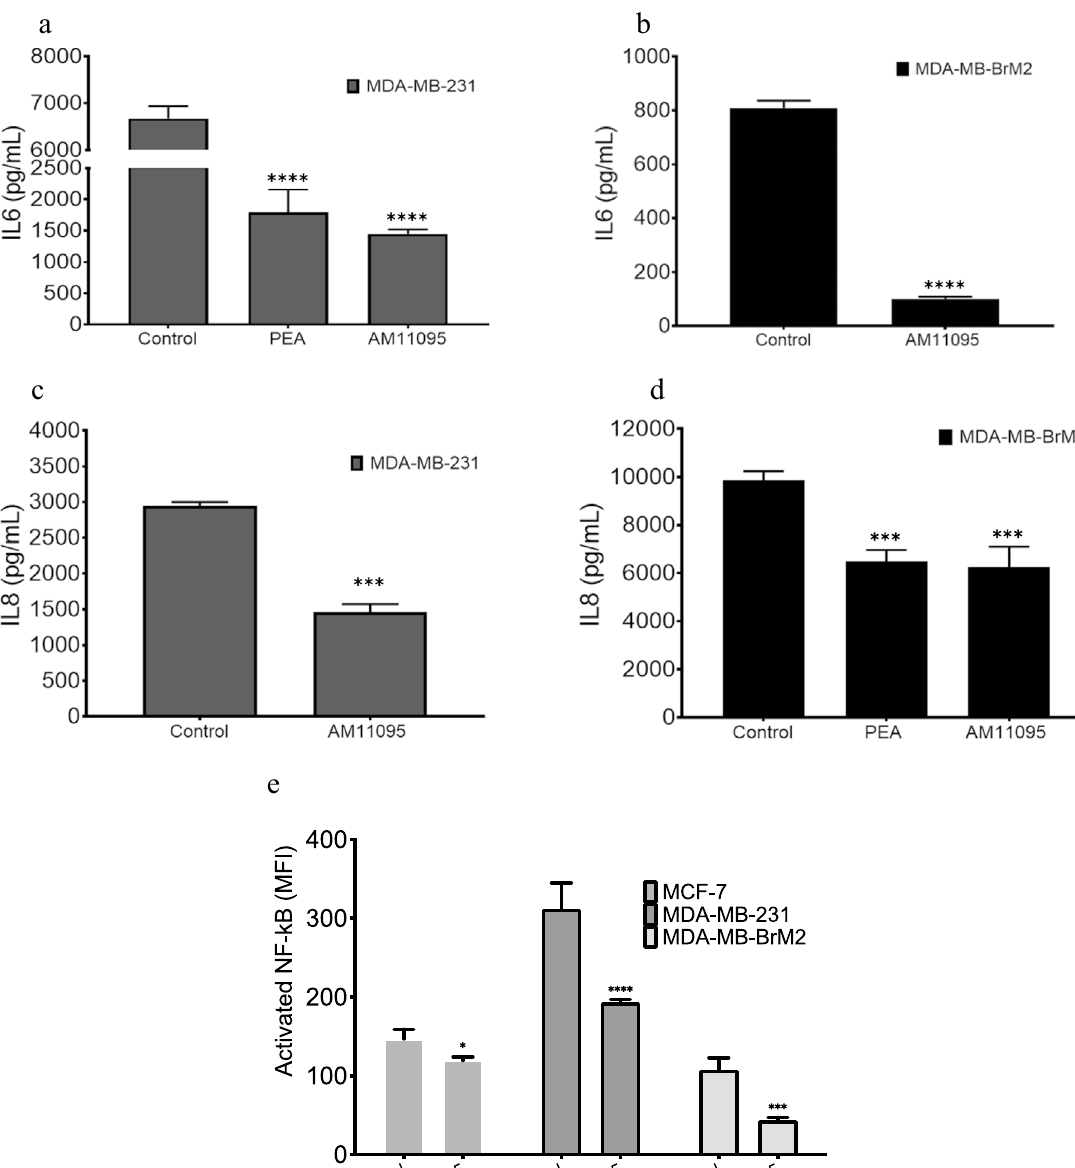
Figure 3. Effects of AM11095 on the expression of chemokines/cytokines. ( a )–( d ) Effect of AM10095 on human cytokines/chemokines expression in MDA-MB-231 and MDA-MB-BrM2 cells was assessed using Luminex kit (MILLIPLEX,). Data were adjusted for background, and then the observed concentrations plotted on a log–log scale. Error bars were calculated using the coefficient of variation (%CV) for each sample from all bead fluorescence intensities between 5th centile and 95th centile (trimmed bead %CV). The p-values were calculated by Unpaired Student’s t-Test. ( e ) Effect of NAAA inhibition on the NF-κB activation was assessed by intracellular Bead-based Multiplex Assays using the Luminex technology in cell nuclear samples prepared from breast cancer cells treated with vehicle or AM11095 as